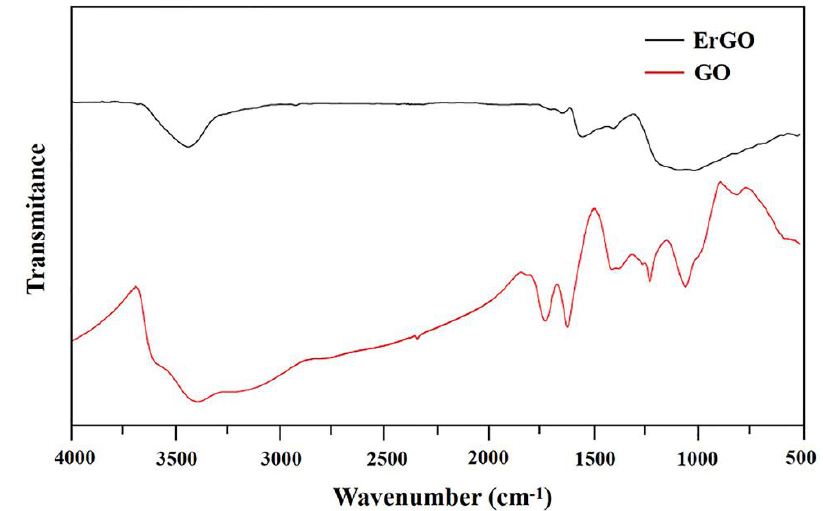
Figure 3. FTIR spectra of graphene oxide (GO) and electro-reduced graphene oxide (ErGO).